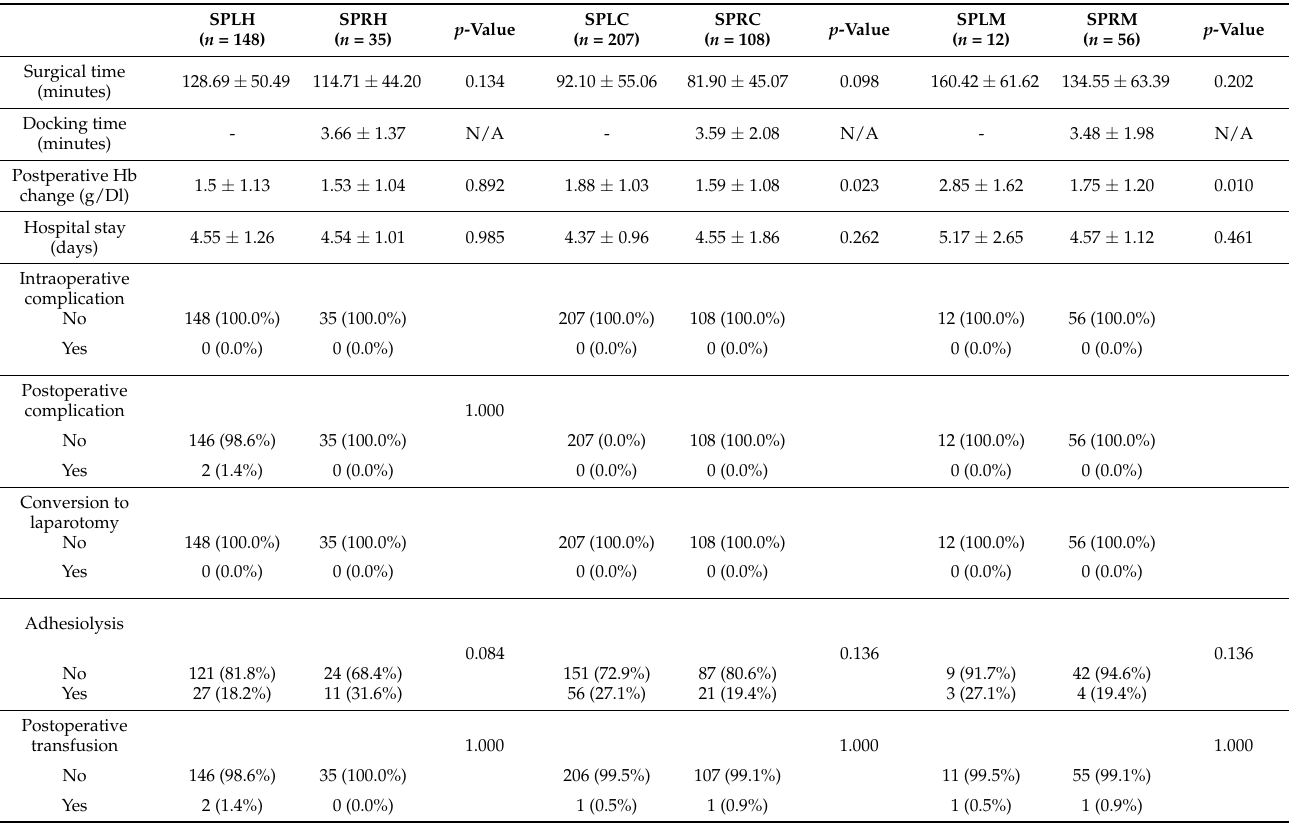
Table 2. Surgical outcomes of SPLH, SPRH, SPLC, SPRC, SPLM, and